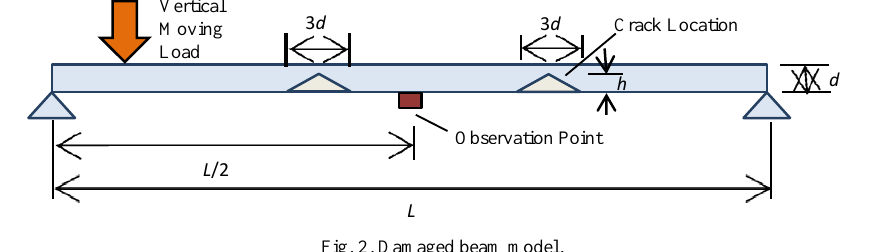
Fig. 2. Damaged beam